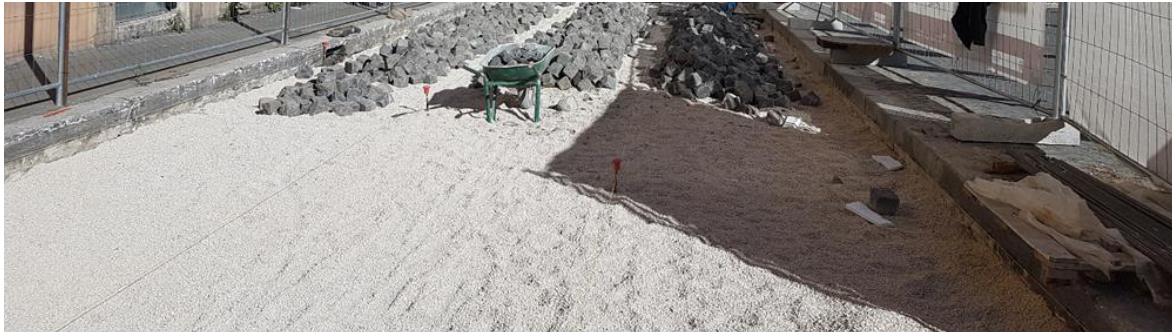
Figure 5. Second phase: dry laying of sampietrini.